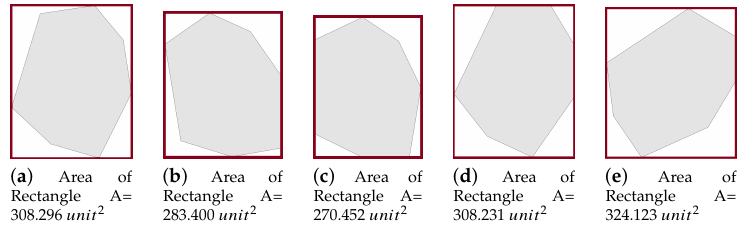
Figure 15. Possible generated rectangles that surrounds the area. The smallest rectangle is represented in ( c ).